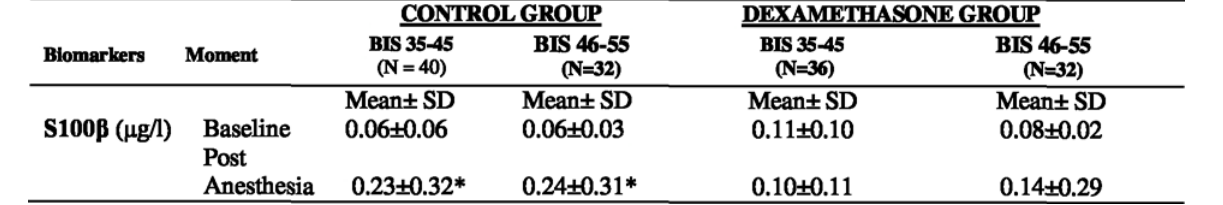
Fig 5. S100 β serum level. BIS: bispectral index; Mean ± SD: Mean ± standard deviation. * = p < 0.05 as compared to baseline biomarkers S100 β